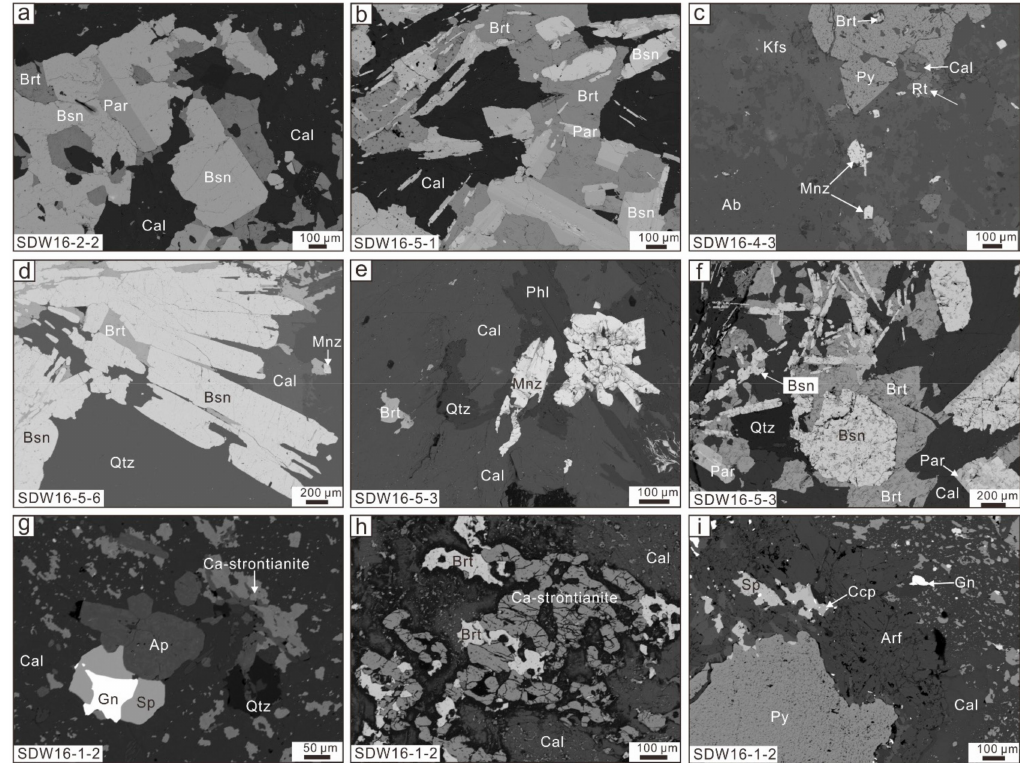
Figure 5. Back-scattered electron images of REE and gangue minerals in the Weishan REE deposit. ( a ) Bastnäsite and parisite crystallized in equilibrium with calcite; euhedral bastnäsite crystals with parisite on its rims; barite formed after or in equilibrium with bastnäsite and parisite. ( b ) Bastnäsite and parisite crystallized in equilibrium with calcite and barite. ( c ) K-feldspar and albite occurring in ores as a relict overprinted by monazite. ( d ) Euhedral bastnäsite crystals with quartz, calcite, and barite, formed after or in equilibrium with bastnäsite. ( e ) Xenomorphic monazite overgrowth on quartz, phlogopite, and calcite, suggesting REE mineralization occurred at a later stage than these minerals. ( f ) Bastnäsite and parisite crystallized in equilibrium with or after calcite and quartz; euhedral bastnäsite crystals formed coevally with parasite, and barite and calcite formed after bastnäsite and parisite. ( g ) Galena formed coevally with barite and overgrown by sphalerite, quartz, calcite, bastnäsite; barite in equilibrium with galena overgrown by sphalerite; barite overprinted by monazite. ( h ) Ca-strontianite and barite in equilibrium with calcite. ( i ) Pyrite, arfvedsonite, and calcite formed coevally and overprinted by sphalerite, chalcopyrite, and galena. Ab = albite; Ap = apatite; Arf = arfvedsonite; Brt = barite; Bsn = bastnäsite; Brt = barite; Bt = biotite; Cal = calcite; Ccp = chalcopyrite; Gn = galena; Kfs = K-feldspar; Mnz = monazite; Par = parasite; Phl = phlogopite; Py = pyrite; Qtz = quartz; Sp =